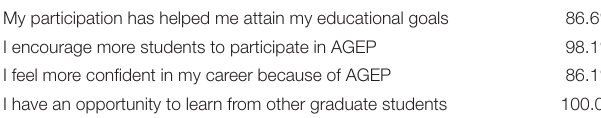
TABLE 4 | Community interaction